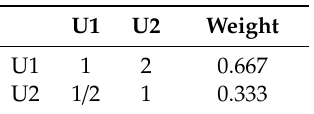
Table A5. Pairwise comparison matrix of urban use indicators.